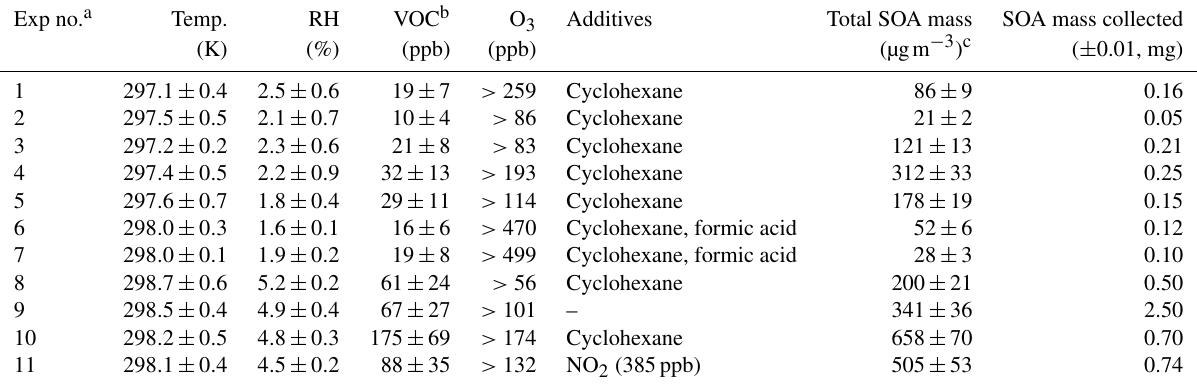
Table 1. Experimental conditions (from the companion paper) and SOA collection information for chamber experiments. Exp no. a Temp. Additives Total SOA mass SOA mass